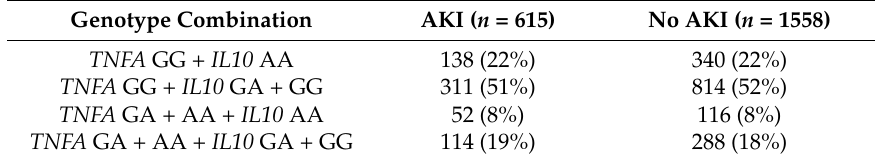
Table 3. Number of patients (percentage) with TNFA rs1800629 and IL10 rs1800896 genotype combinations. Genotypes are grouped according to the reported effect in protein production. Acute kidney injury (AKI) KDIGO stages 2 and 3 (cases) compared to stage 0